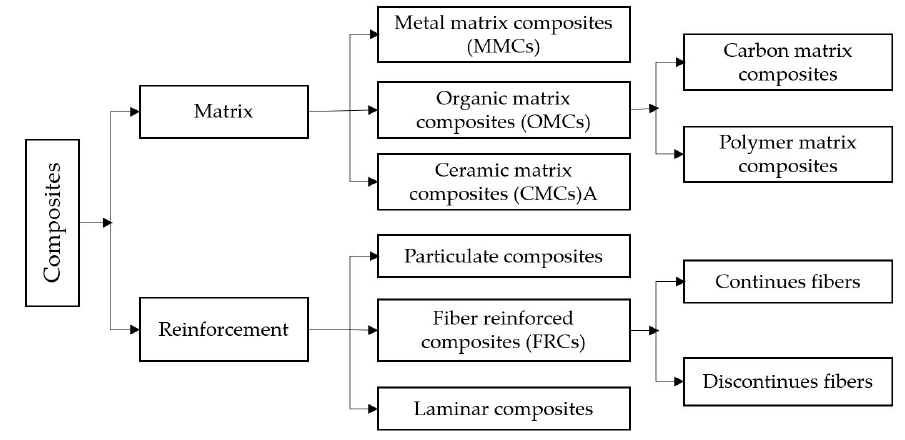
Figure 3. Classification of composites [22].